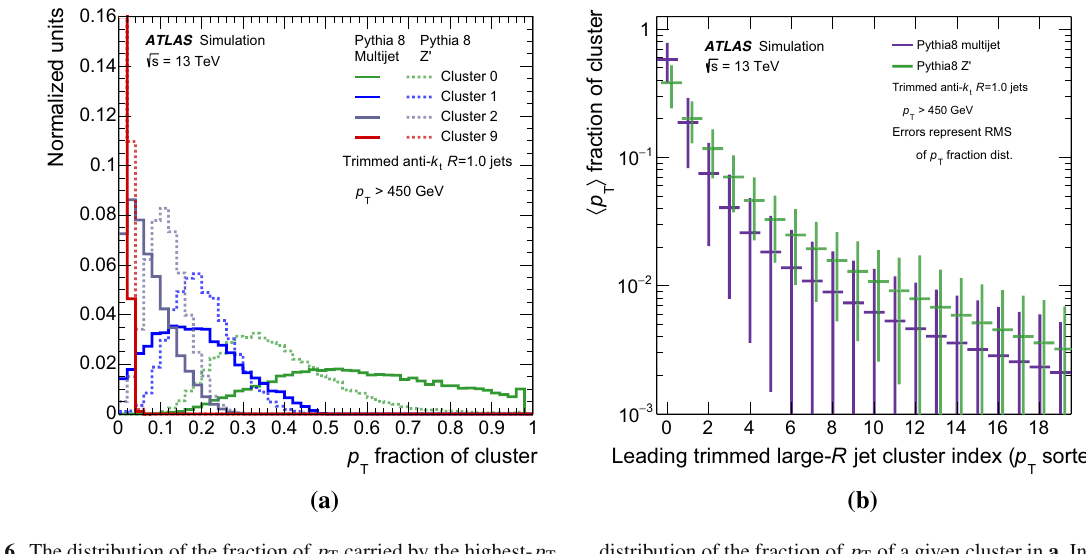
distribution of the fraction of p T of a given cluster in a . In a , the distri- bution for the tenth-highest- p T cluster (Cluster 9) extends beyond the maximum value of the vertical axis. The light-quark jet sample is taken fromjetsthatpassthemultijetselectionasdescribedinSect.6.2.1while the top-quark jet sample is taken from jets that pass the semileptonic selection as described in Sect.